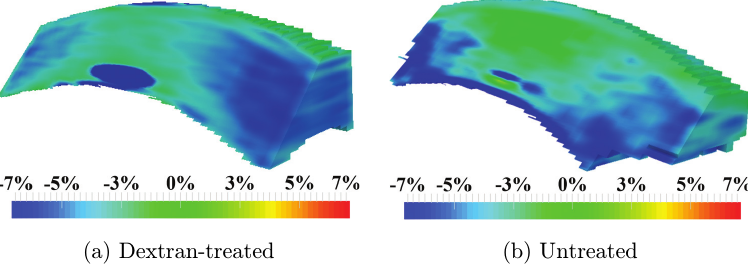
Fig. 5. (Color online) Maps of the third principal strain " 3 obtained in (a) dextran-treated, and (b) untreated globes after in°ation from 10 mmHg to 12 mmHg.